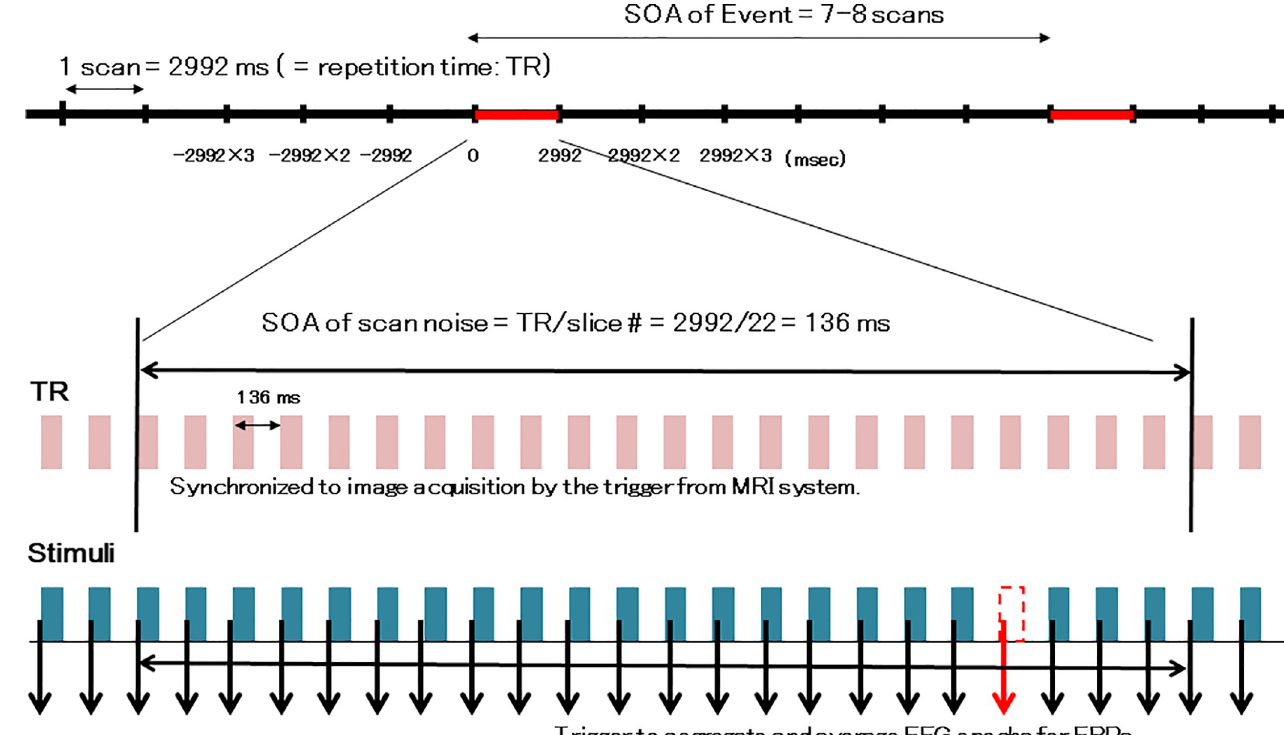
Fig 1. Schematic of functional magnetic resonance imaging (fMRI) data acquisition using an event-related design. We used an event-related design for the fMRI. Scans of 22 slices generated equal numbers of scan noises during a single repetition time (TR) of 2992 ms, and the same number of tones with a stimulus onset asynchrony (SOA) of 136 ms (TR/slice number = 2992/22) were presented. The presentation of tones was completely synchronized to scans by triggers generated by the MRI system in order to minimize the effect of scan noise on fMRI and electroencephalogram (EEG) raw data, which were also used to segregate and average EEG epochs in the ERP analysis. The SOA for event scans including the omission events and tones in the regular positions represent 7 or 8 scans (20,944 or 23,936 ms). Fifty-three event scans were assorted at random among the 247 baseline scans including baseline tones only, with no omission. Total scan time = 2992 ms x 300 scans = 897,600 ms. Event: scan including omission 53 times, indicated by red crossbars. Baseline: scan including only frequent stimuli 247 times, indicated by black crossbars. Frequent stimuli: 6547 trials, 3000 Hz, duration 35 ms, rise/fall 0/5 ms. Rare (omission) events: 53 trials (probability: 53/6600 =